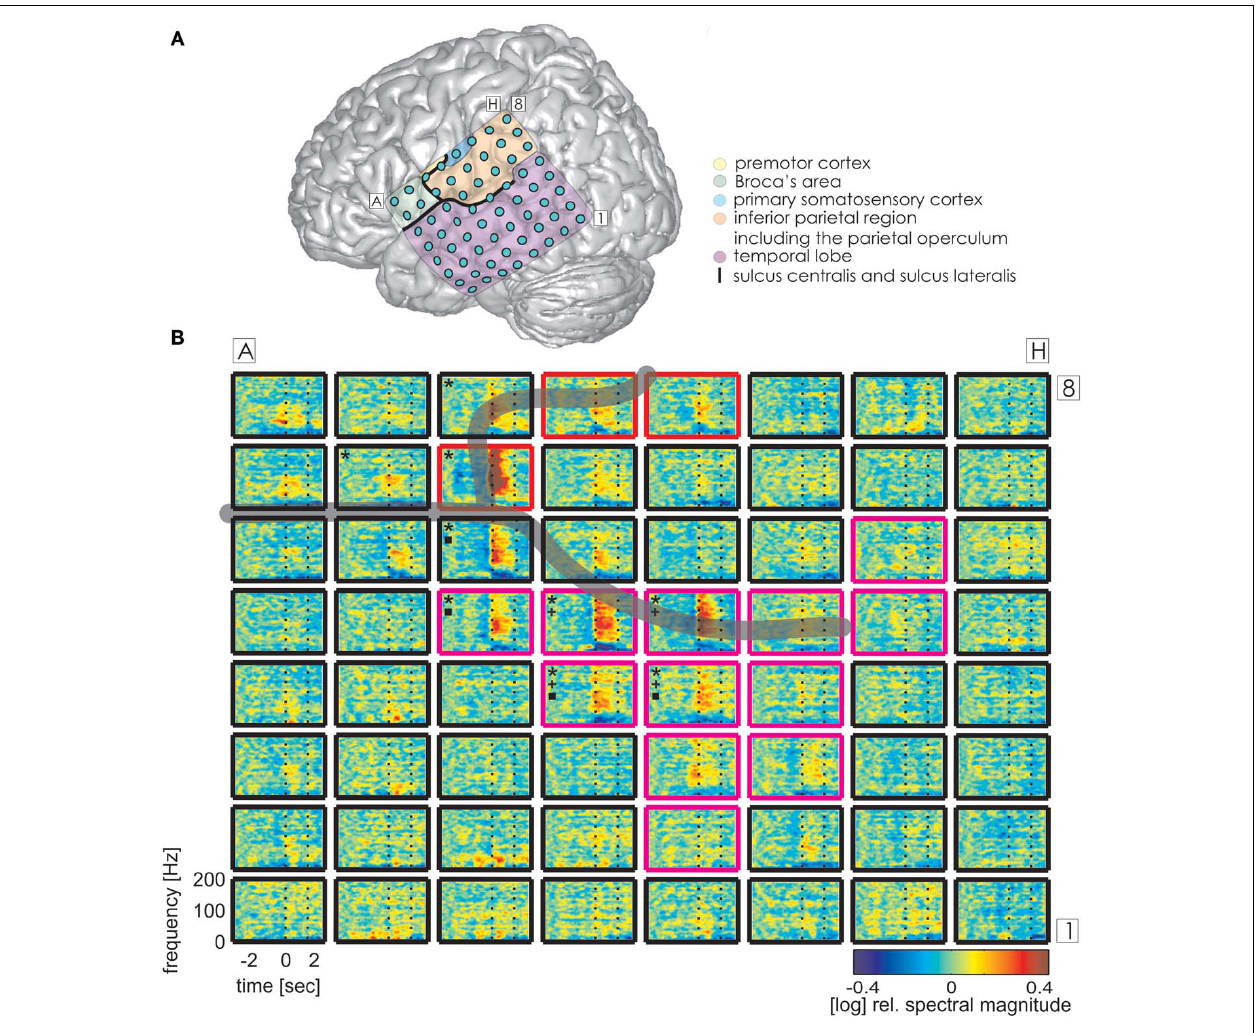
FIGURE 4 | Trial-averaged, time-resolved relative spectral magnitude changes of IU-related brain activity in S3. (A) The individual location and anatomical assignment of the electrodes. (B) Cortical responses underlying the production of IUs averaged across 141 trials. Other details as in Figure 3